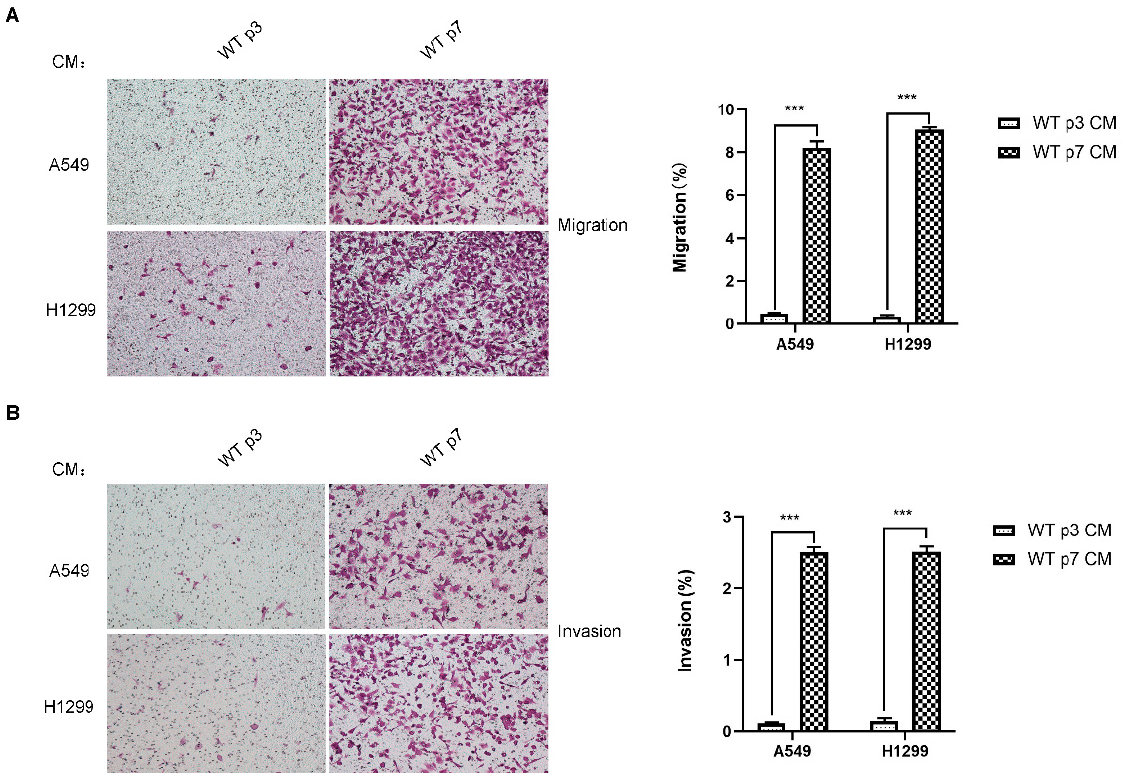
Figure 2. Senescent fibroblasts promote the migration and invasion of lung cancer cells, H1299 and A549. ( A ). Transwell migration assay of H1299 and A549 cells following co-culture with CM from young (p3) and senescent (p7) fibroblasts after 18 h. ( B ). Transwell invasion assay of H1299 and A549 cells following co-culture with CM from young (p3) and senescent (p7) fibroblasts after 18 h. Average migration/invasion ± SEM from three independent experiments performed. Statistical analysis; ***, p < 0.001.